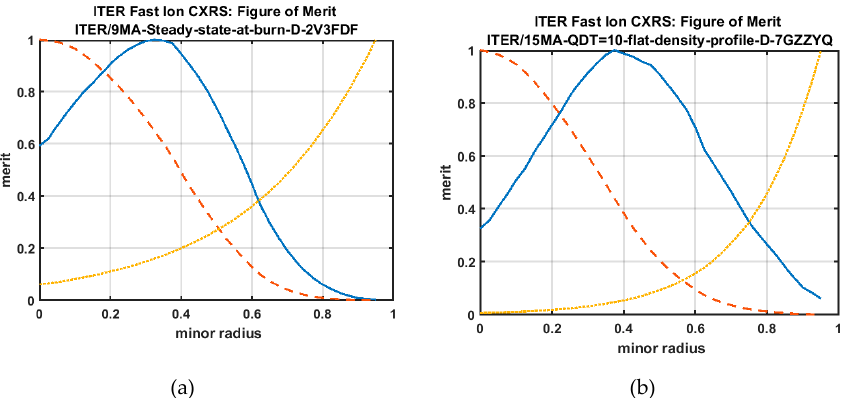
Figure 20 . ( a ) Figure of merit for Fast Ion CXRS on confined alpha particles. Solid line: n fast *n beam (normalized). Dashed line: n fast (max. 2.8 × 10 18 m − 3 ). Dotted line: n beam (max. 3.0 × 10 14 m − 3 ). E-port-3- Upper, DNB 100keV/amu, 36A, 9MA_Steady_state_at_burn_D_2V3FDF; ( b ) Figure of merit for Fast Ion CXRS on confined alpha particles. Solid line: n fast *n beam (normalized). Dashed line: n fast (max. 2.2 × 10 18 m − 3 ). Dotted line: n beam (max. 2.8 × 10 14 m − 3 ). E-port-3-Upper, DNB 100keV/amu,